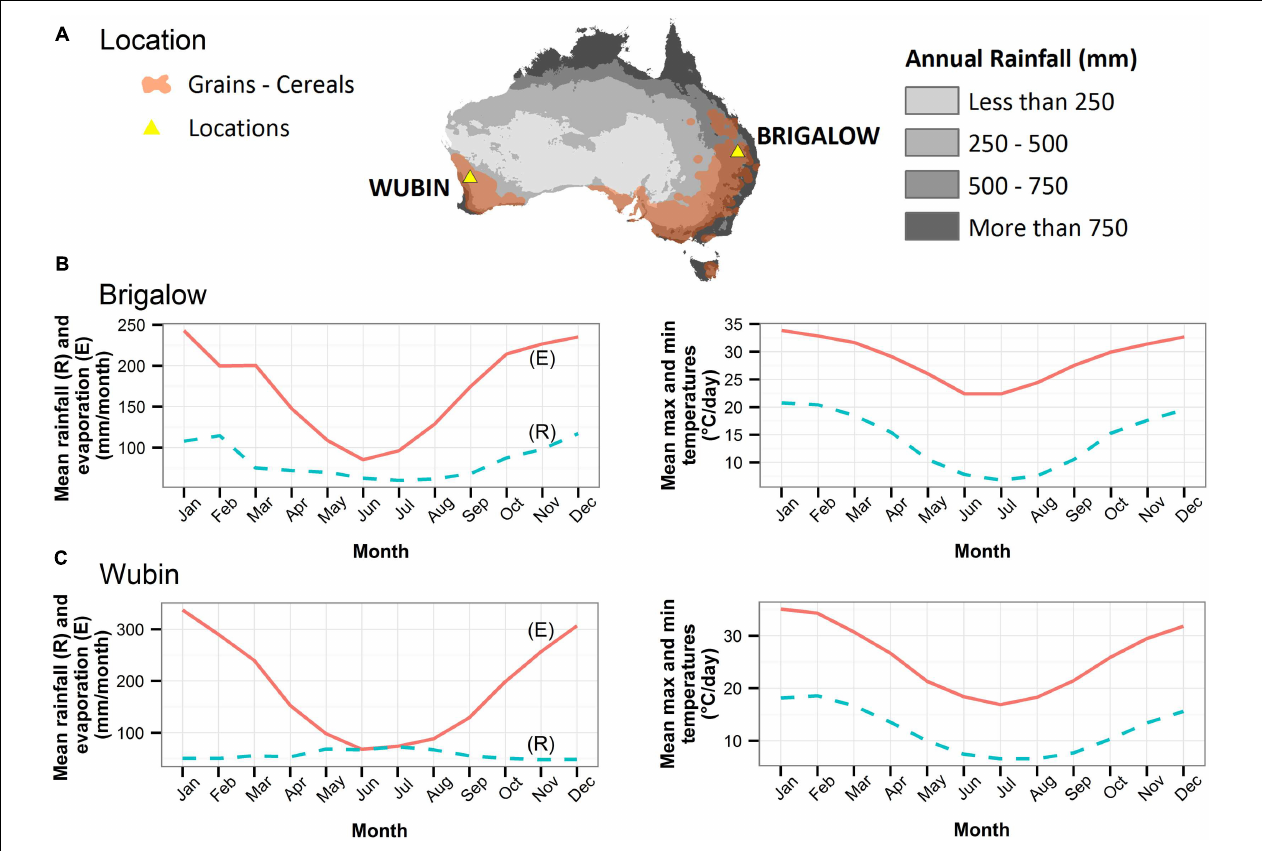
FIGURE 2 | Locations of Wubin, Brigalow, grain production regions, and rainfall areas (A). Average monthly values for rainfall (R), pan evaporation (E), maximum daily temperature and minimum daily temperature for Brigalow (B) and Wubin (C) (Jeffrey et al., 2001). National climate data from Australian Government - Bureau of Meteorology (n.d.).